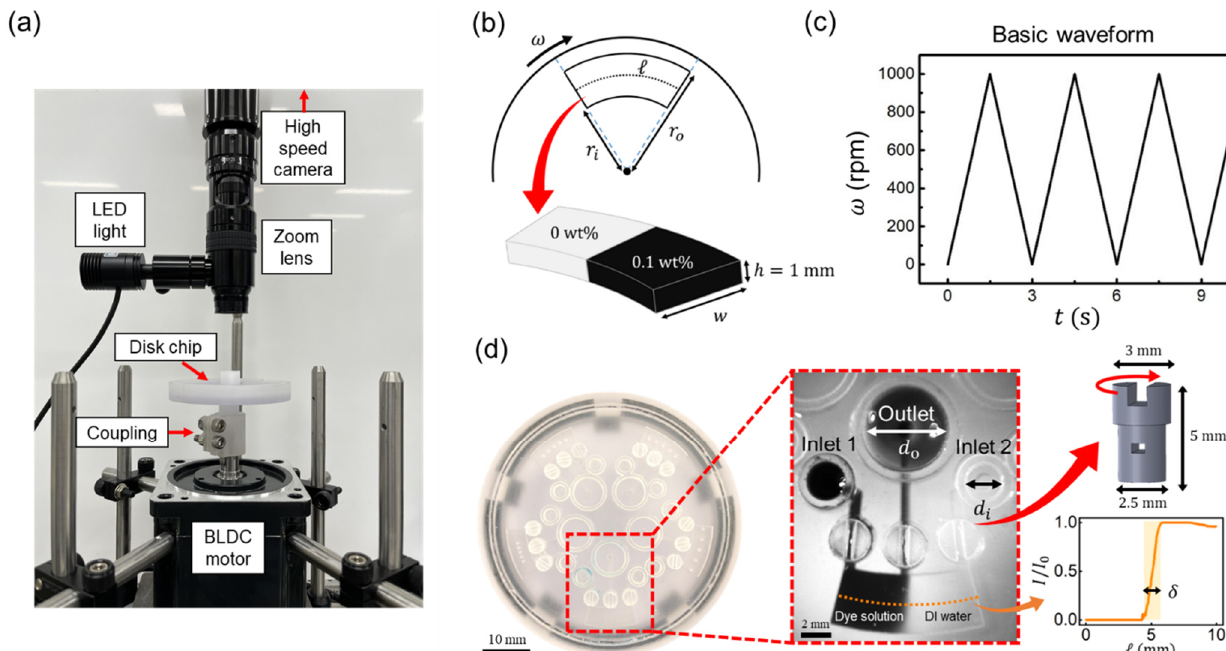
Figure 1. ( a ). Figure 1. ( a ) Experimental setup; the 3D printed disk is rotated by the BLDC motor. The 3D-printed coupling was used to link the BLDC motor and the 3D-printed disk chip to the motor. A high-speed camera with a zoom lens and an LED light was used to capture the mixing process. ( b ) Schematic of the rotational mixing chamber, where, r i and r o are the inner and outer radii of the chamber, respectively. Here, w is the radial width of the chamber, (cid:96) is the arc length of the midpoint of the outer and inner radii, and h is the height of the chamber. Initially, the chamber contained a 0.1 wt.% of dye solution and DI water. ( c ) As a basic rotational condition, the rotational velocity ( ω ) and period were set as a triangular waveform with a maximum ω of 1000 rpm, a period of 3 s, and a total of 6 cycles. ( d ) The series of rotational type mixers in a disk and the magnification of the chamber mixer. The two different solutions were initially placed in the chamber using inlets 1 and 2, the outlet, and three mechanical valves. d i and d o are inlet and outlet reservoir diameters for gentle injection using capillary pressure. After injecting each solution, the inlets and outlet were closed by rotating the screw valve. Before mixing, the solution showed a sharp interface between the dye and DI water, and the interfacial thickness ( δ ) was measured to be ~1.4